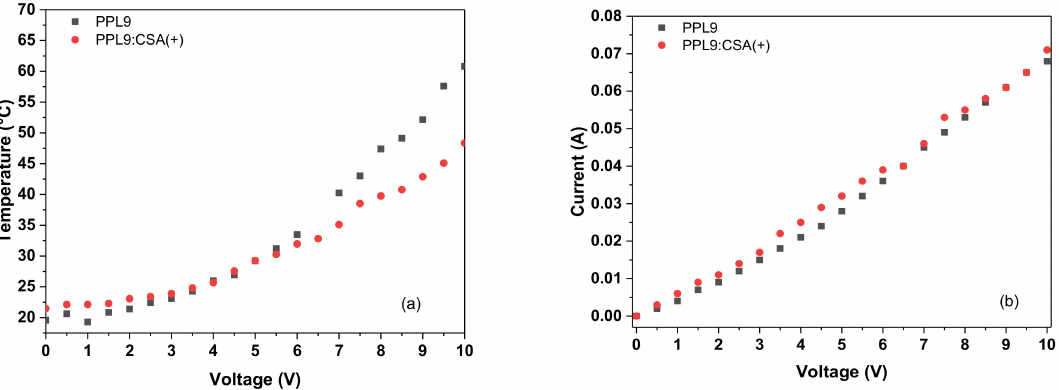
Figure 9. Correlation of temperature ( a ) and current ( b ) versus applied potential for constructed devices containing PPL9 and its protonated form with